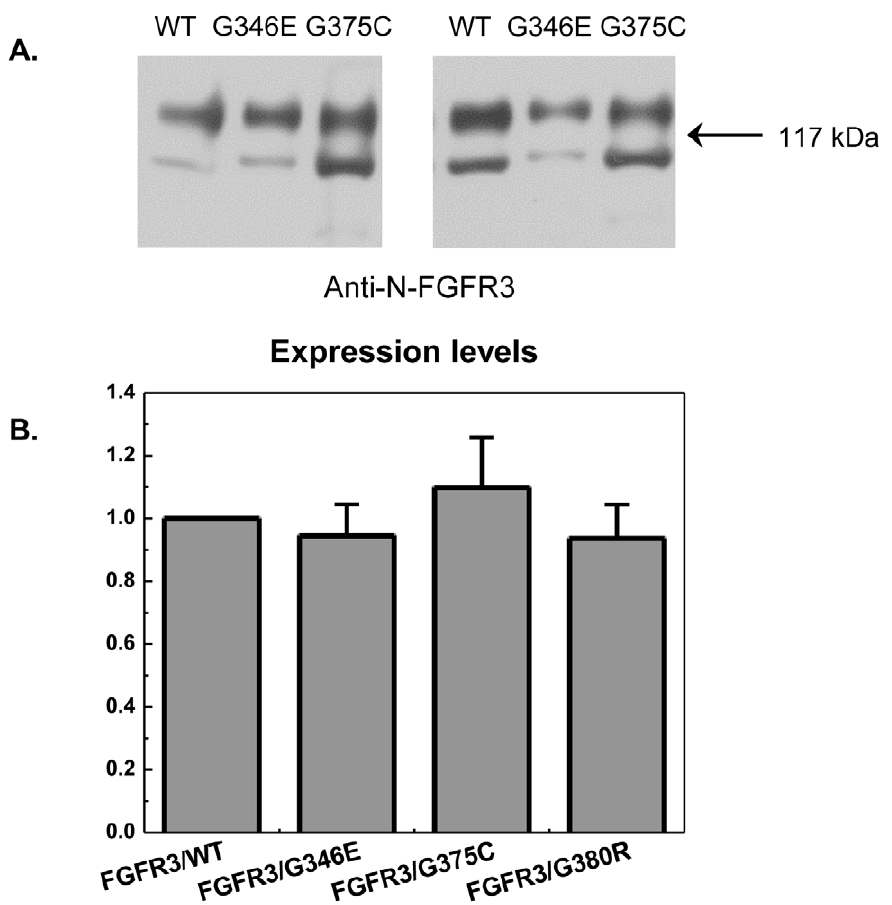
Figure 1. FGFR3 expression patterns in HEK 293 cells. Cells were transfected with 2 m g/well of DNA encoding FGFR3/WT, FGFR3/G346E, or FGFR3/G375C. 24 hours after transfection, cells were starved in serum-free medium, followed by cell lysis. The cell lysates were subjected to Western blotting, and FGFR expression was probed using anti-N-FGFR3 antibodies. A. Two representative blots, showing the expression of FGFR3/WT, FGFR3/ G346E and FGFR3/G375C. B. Quantification of the expression of the 130 kDa mature FGFR3, based on results from ten independent experiments. There are no statistical differences between the expressions of the wild-type and the three mutants (p . 0.017, see text). Data for the G380R mutant are from